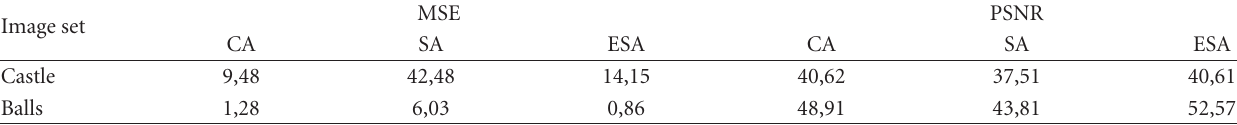
Table 2: MSE and PSNR characteristics of the three fusion methods applied to the tested